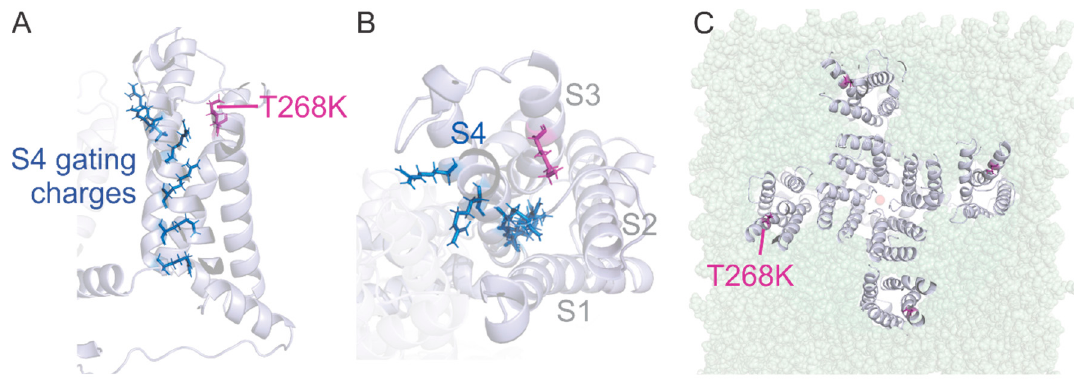
Figure 5. Side view ( A ) and top view ( B ) of one voltage sensor domain of the homology model of the Kv1.1 channel built upon the crystal structure of Kv1.2–Kv2.1 chimera showing the localization of the T268K mutation. T268K is highlighted in magenta and gating charges in S4 as blue sticks. ( C ) Position of the T268K mutation with respect to the lipid membrane.